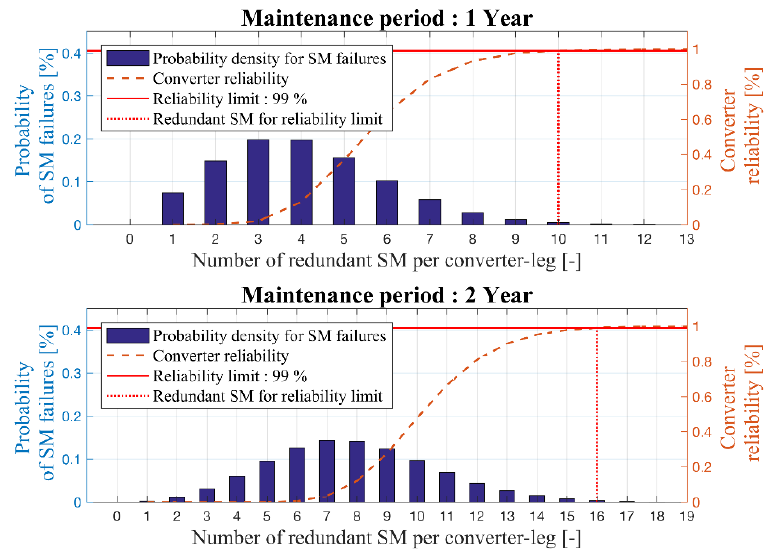
Figure 4. Converter reliability and probability of SM failure over the number of redundant SM after one and two year maintenance period.